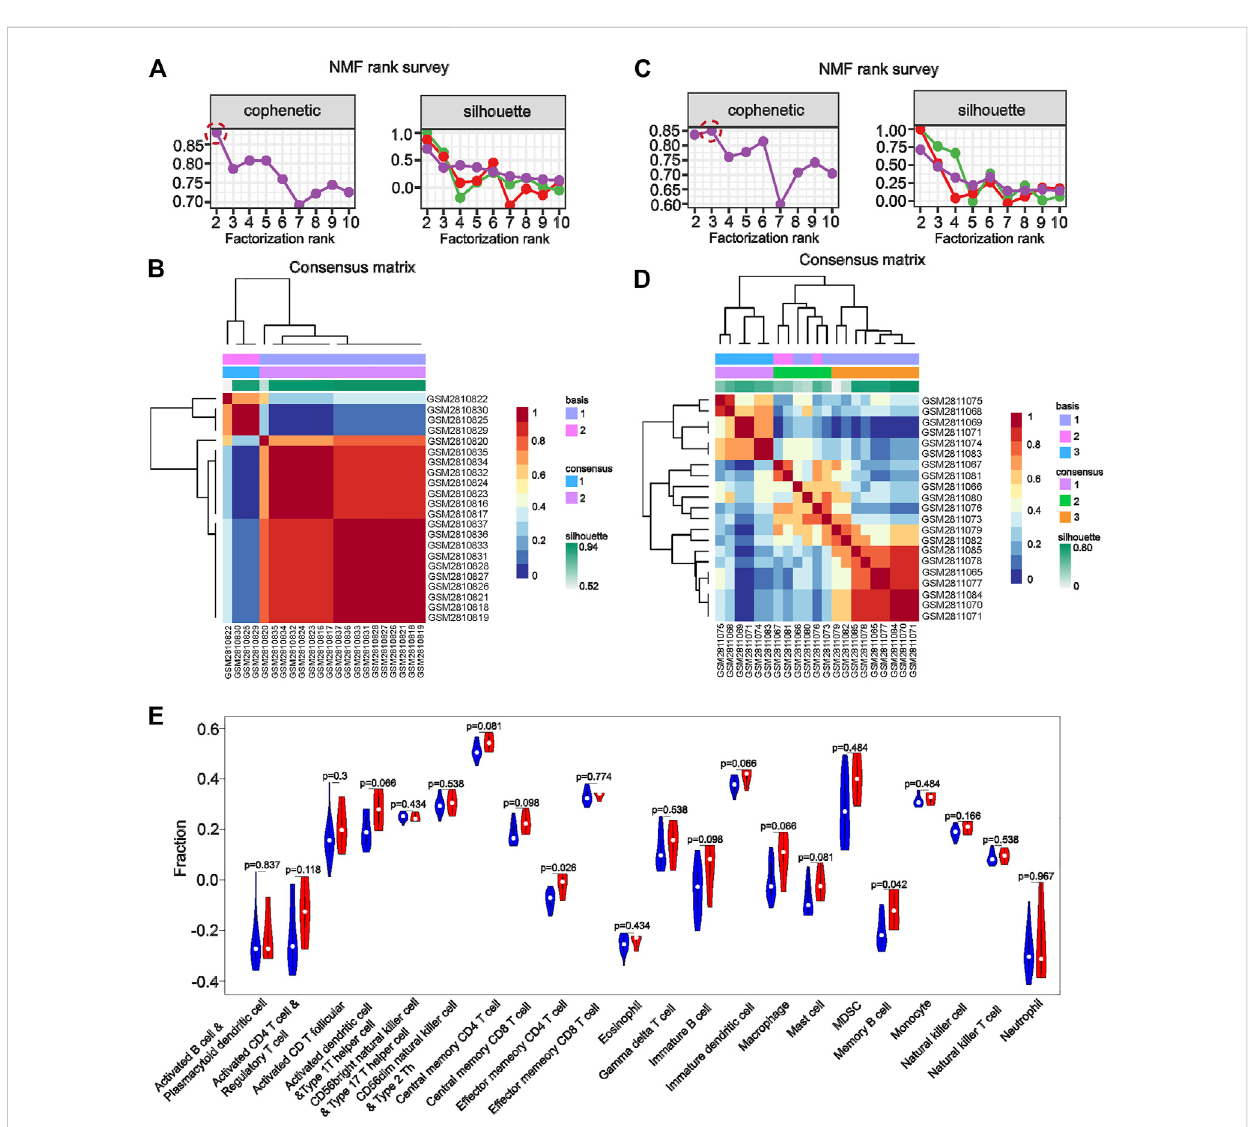
FIGURE 5 Non-negativematrixfactorization clustering witheightco – keygenesormolecularsubtypeidenti fi cationintheglomerulardatasetGSE104948and thetubulardatasetGSE104954. (A,C) Thesharpdecreaseinthecopheneticcorrelationcoef fi cientatrankr=2indicatesthatco-keygenescouldclassify glomerular disease in anti-neutrophil cytoplasmic antibody – associated vasculitis (AAV)-related kidney injury into two subgroups. (B, D) In the tubular datasetGSE104954, thehighestcopheneticcorrelationcoef fi cientatrank r=3suggested thattheco-keygenescouldclassify renaltubulardisease in AAV-related kidney injury into three subgroups. (E) . Immune cell in fi ltration of AAV-glomerular injury molecular subtypes. Immune in fi ltration analysis of molecular subtypes endows subtypes with immunological signi fi cance to the disease. High expression of both subtypes in a particular immune cell may suggest that the immune cell was essential to disease development The statistical differences obtained by comparing one subtypes with another subtype imply that a certain subtype plays a major role in that single immune